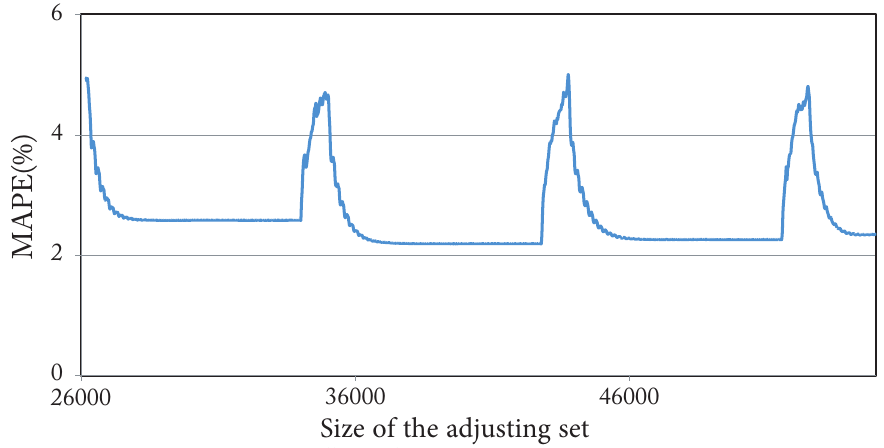
( hours ) Figure 6. MAPE of the forecasts for 24-hours ahead according to the size of the dataset used to obtain the AMC 24,168,8766